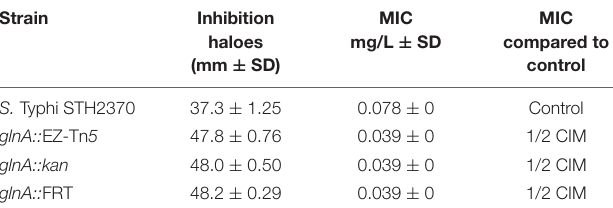
TABLE 2 | Susceptibility to ciprofloxacin of WT S. Typhi and null mutants in glnA